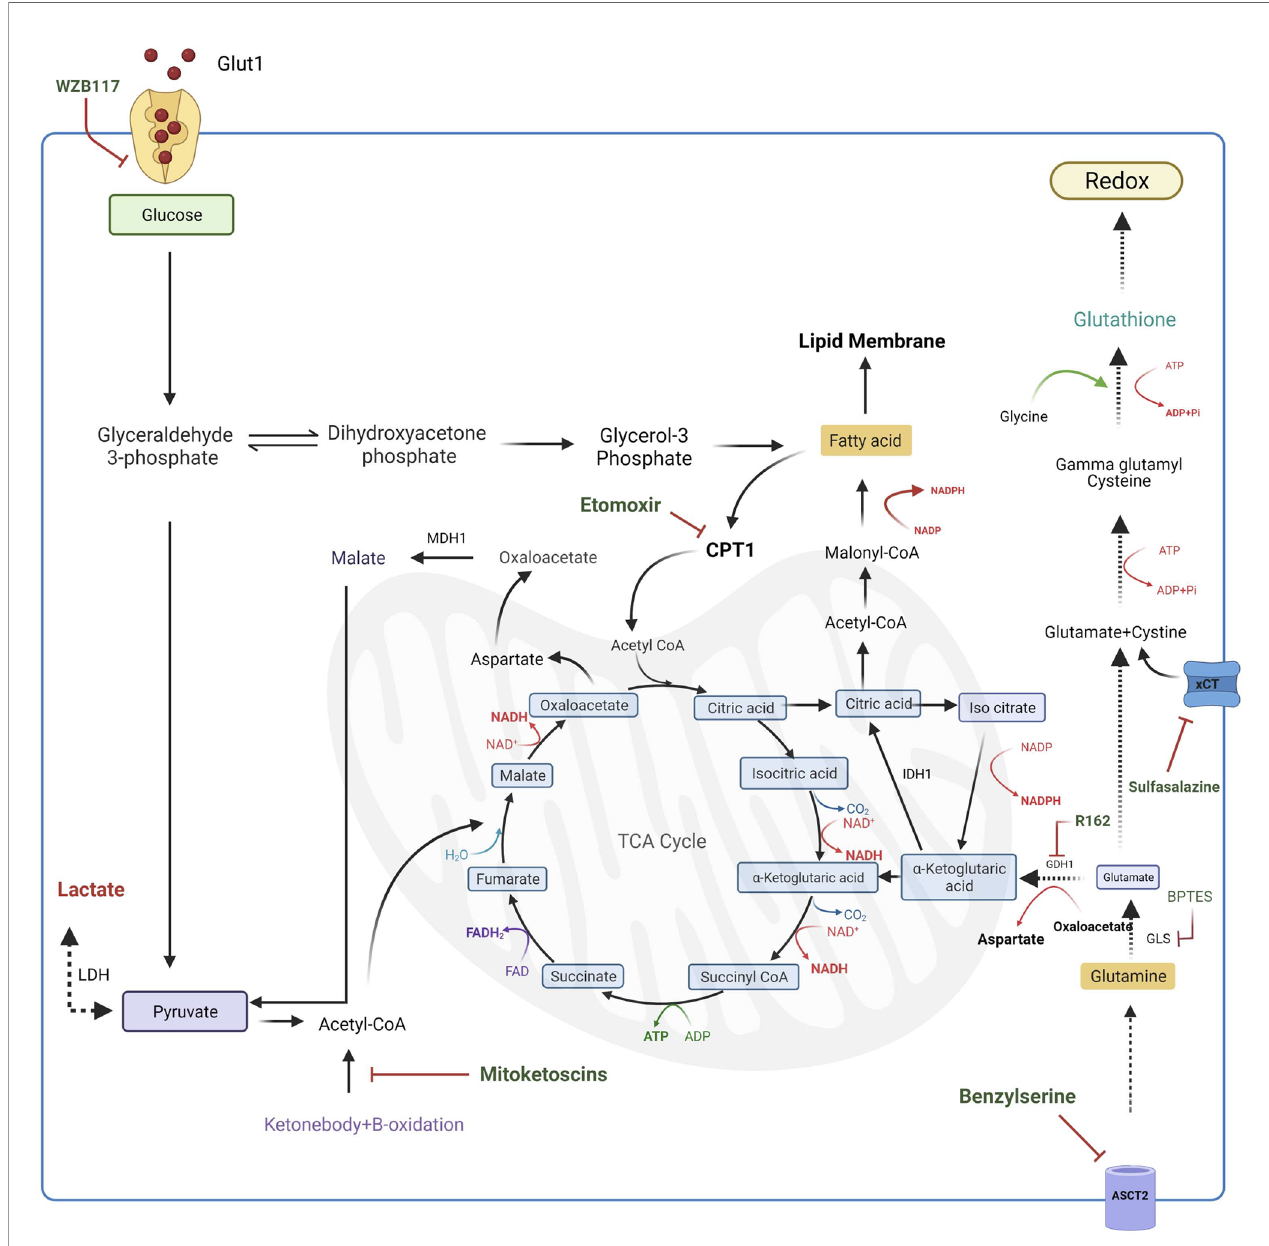
FIGURE 4 | Targeting of metabolic pathways in CSCs. Several compounds inhibit different metabolic intermediates in CSCs. Glut1 uptake can be inhibited by WZB11 treatment resulting in a lower energy production. Also targeting the glutamine metabolism represents a potential strategy to apply in cancer treatment. Indeed, inhibition of ASCT2 transporter with Benzylserine prevents the glutamine uptake while blocking the metabolic intermediates, such as GLS with BTES, hinders glutaminolysis. Moreover, glutamate deriving from processed glutamine, together with intracellular cysteine, can participate in glutathione synthesis that is responsible for low ROS maintenance. Another strategy to increase CSCs death is the reduction of cysteine uptake by inhibition of xCT transporter with Sulfasalazine. CSCs survival can be also hampered by targeting the conversion of ketonebodies into Acetyl-CoA, a substrate necessary for TCA cycle. Moreover, also lipid entering in TCA cycle can be inhibited using selective inhibitors of enzymes involved in lipid metabolism. Indeed, treatment of CSCs with Etomoxir, results in the CPT1 enzyme inactivation resulting in the cytosolic accumulation of lipidic intermediates. TCA, tricarboxylic acid cycle; G6PD, Glucose-6-phosphate dehydrogenase; LDH, lactate dehydrogenase; GLS, glutaminase; GDH1, glutamate dehydrogenase 1; ASCT2, Alanine/Serine/Cysteine-preferring Transporter 2; IDH1, isocitrate dehydrogenase; xCT, cysteine/glutamate transporter; CPT1, carnitine palmitoyltransferase 1; MDH1, malate dehydrogenase; BPTES, bis-2-(5-phenylacetamido-1,3,4-thiadiazol-2-yl) ethyl sul fi